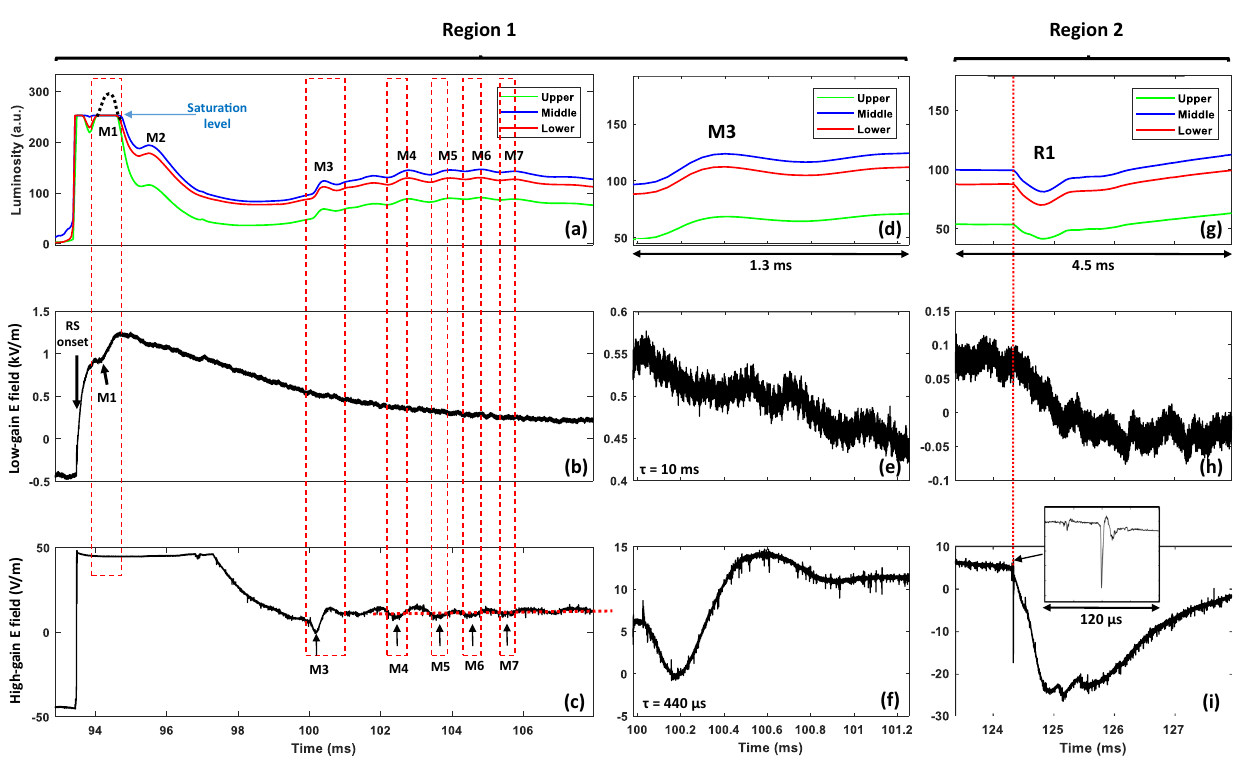
Fig. 8 Two-stroke positive Flash 2014, Stroke 2. a – c Expansion of Region 1 labeled in Fig. 7, showing M-components M1 to M7. M1 occurred about 0.5 ms after the RS onset. d – f are the same as a – c , respectively, but shown on an expanded (1.3 ms) time scale, to magnify M-component M3. g – i Expansion of Region 2 labeled in Fig. 7, showing event R1 (luminosity